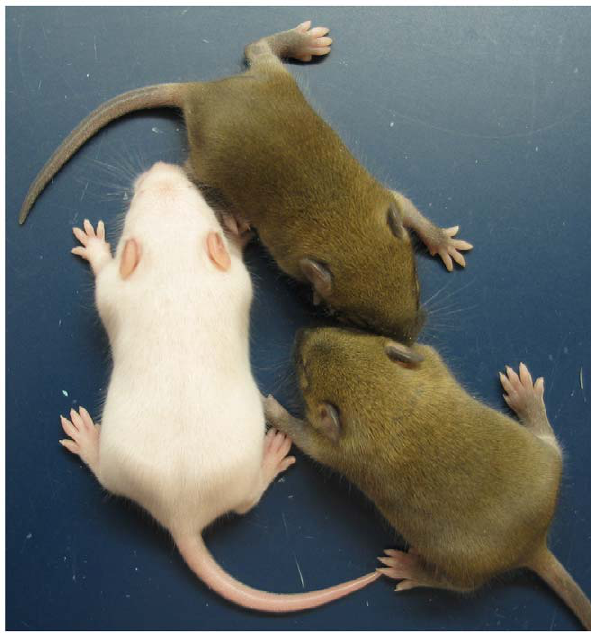
Figure 4. Neonatal MatDup.dist7 mouse rescued by ICR D . MatDup.dist7 (ICR D . + , Cdkn1c + . + ) albino neonate with two agouti littermates at 10 days post-partum. Mating scheme to breed these animals was as described in the legend to Figure